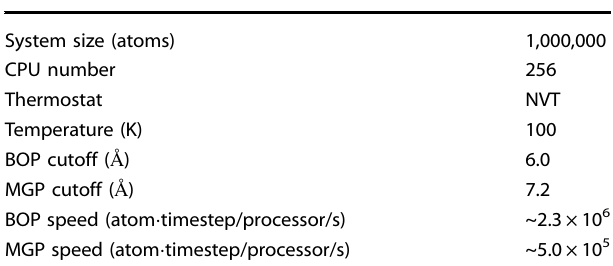
Table 1. Performance in